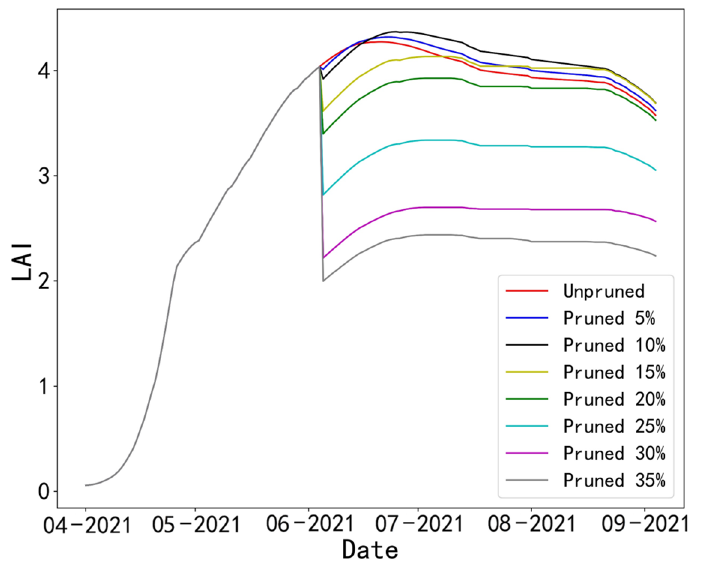
Figure 11. Results of LAI simulated under different pruning intensities (Alaer) based on modified model.